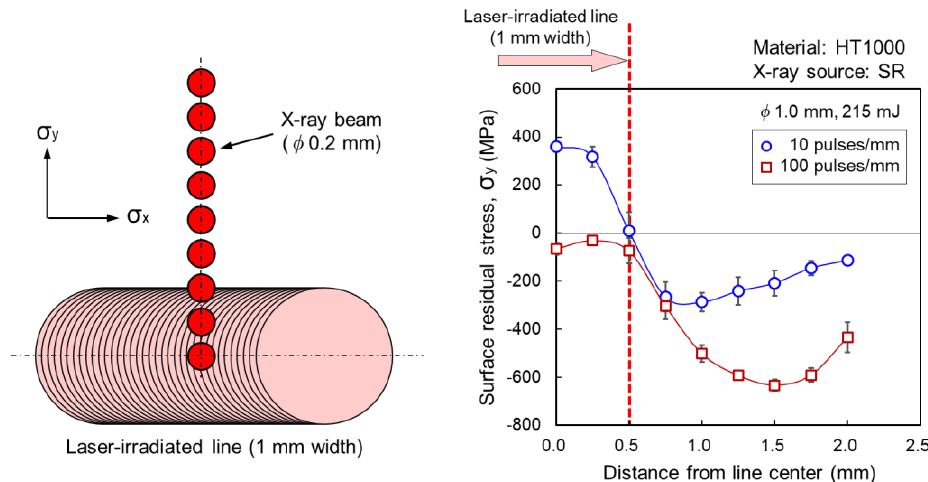
Figure 5. Profiles of surface RS in the y-direction across laser-irradiated lines.